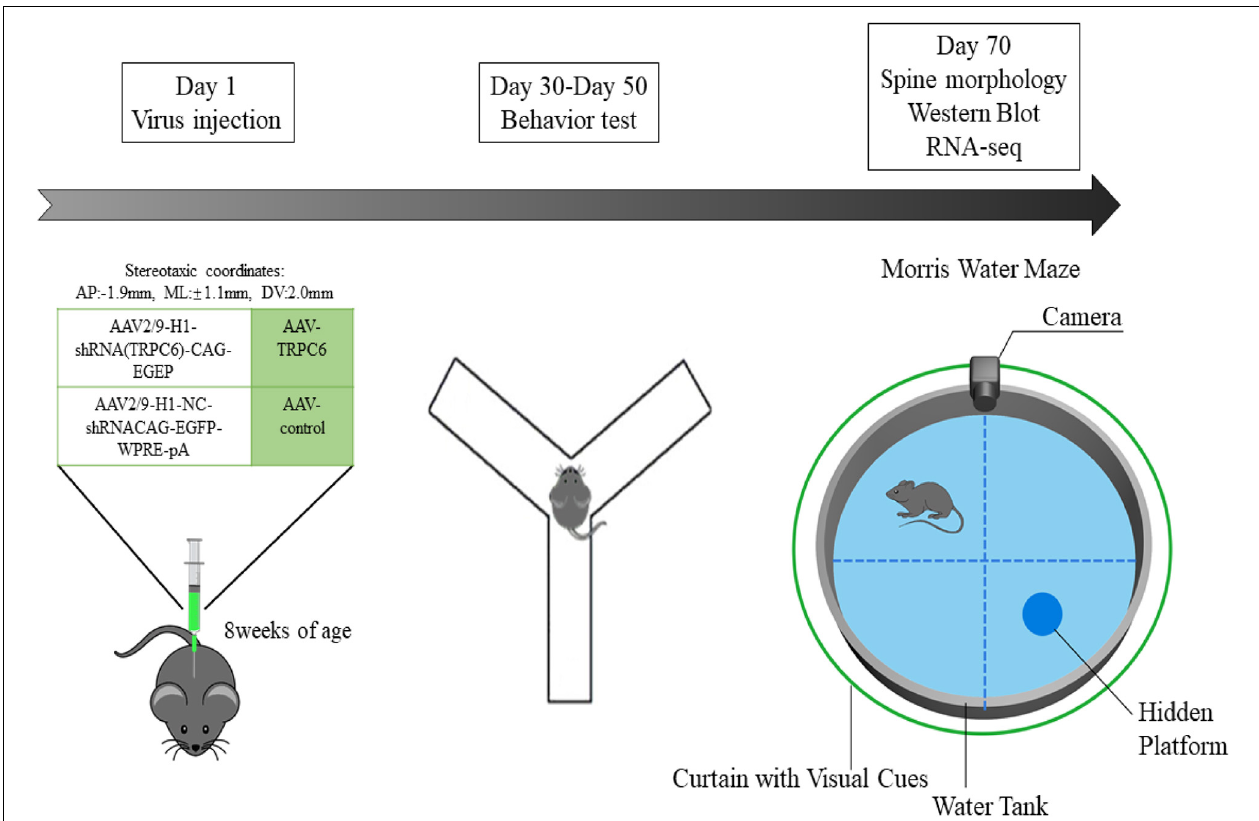
FIGURE 1 | Scheme of the expe rimental design. In the first experimental phase, we administered different viral injections to two groups of mice to explore the role of TRPC6 in the DG region of the hippocampus. In the second experimental phase, also 28 days after virus injection, the animals were used for behavioral studies on Nest building, Y-maze, NOR, Open field, Three-chamber sociability and Morris water maze. Later, in the third experimental phase, we performed Western blotting, qRT-PCR, RNA-seq, immunofluorescence and spine morphology studies.